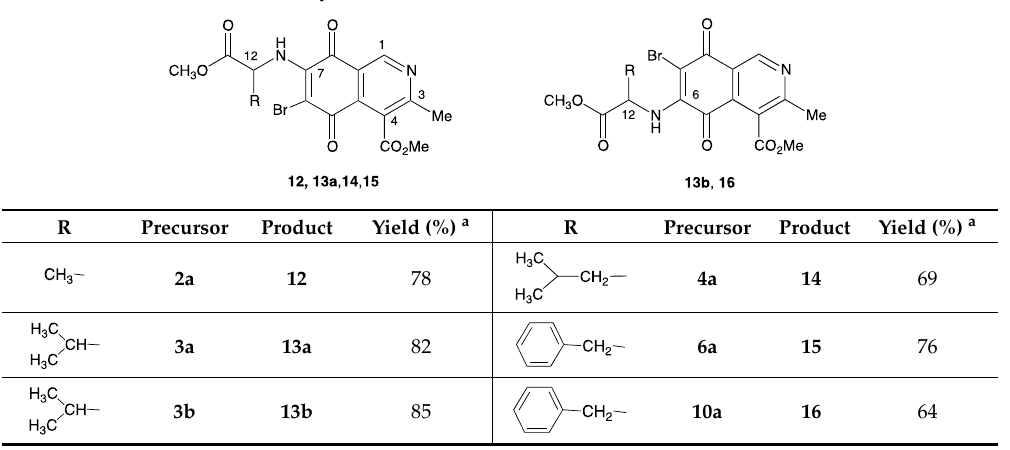
Table 2. Yields of the synthesized bromine derivatives 12 , 13a , 13b , 14 , 15 , and 16 .